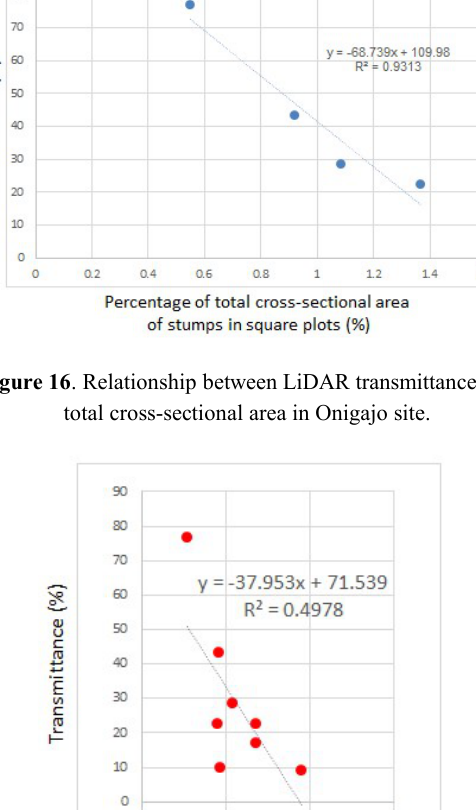
Figure 15 . Tree density distribution map in the part of the Yadaijin site of the Abukuma Granite area.